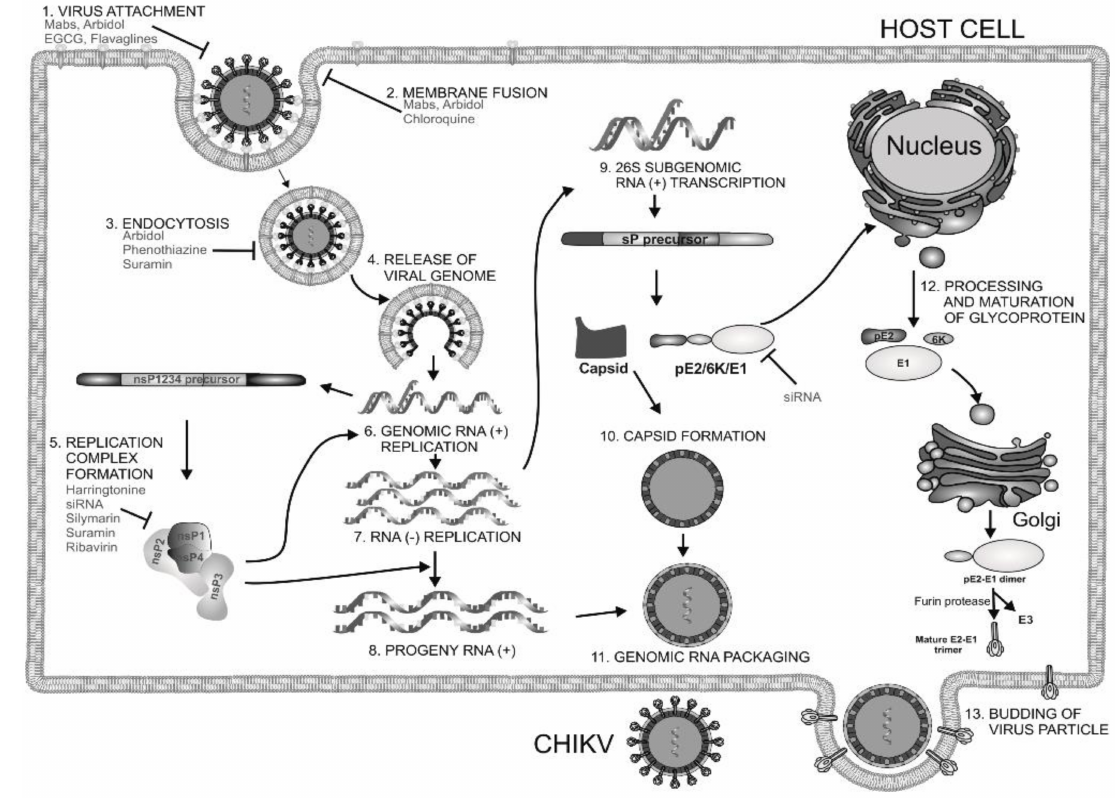
Figure 1. Chikungunya virus (CHIKV) replication cycle and interference by CHIKV inhibitors. CHIKV attaches (1) to the host cell, after which, it is endocytosed (3). The viral envelope and